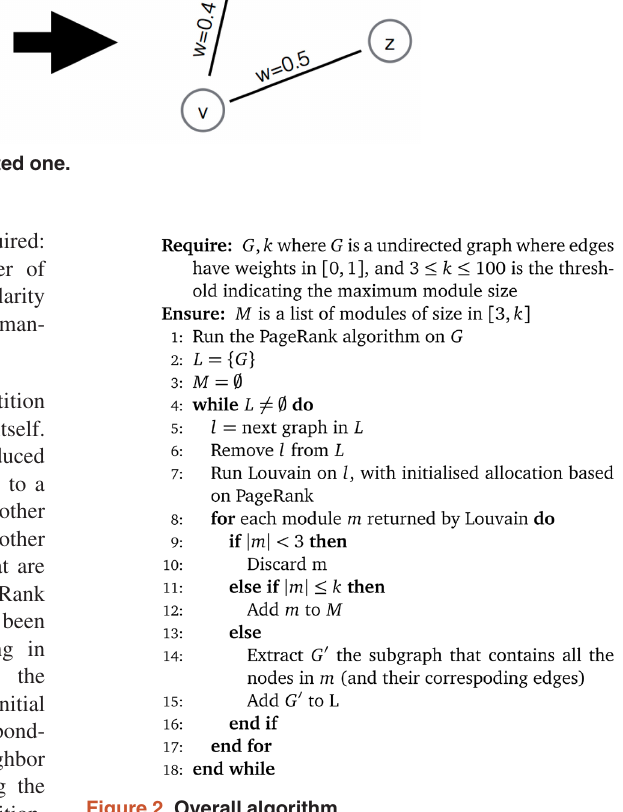
Figure 2. Overall